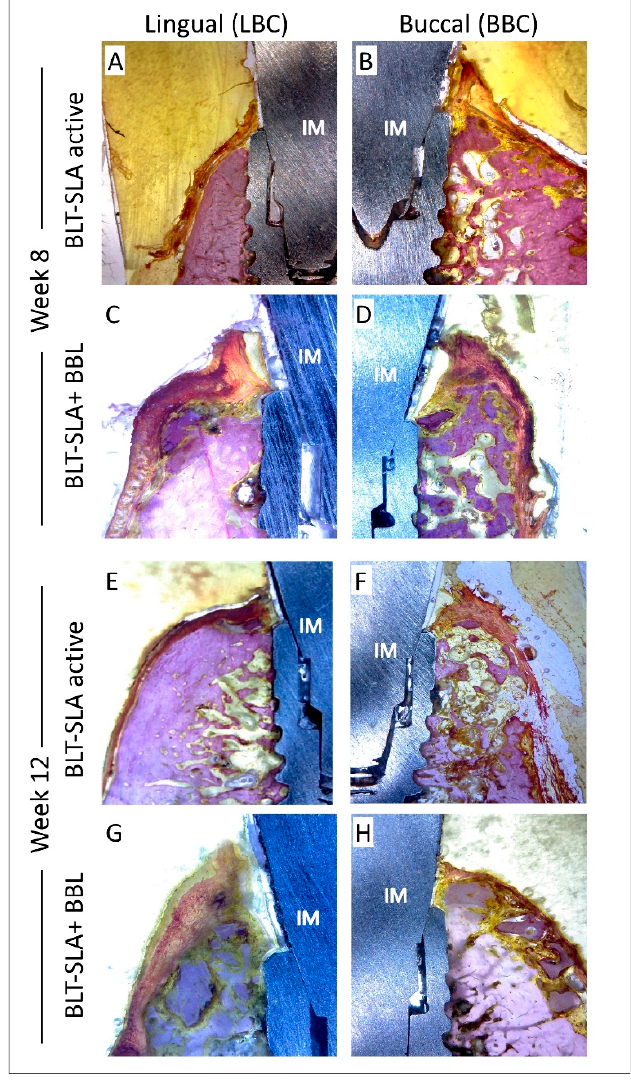
Figure 5. Representative image illustrating the crestal bone loss at week 8 ( A – D ) and 12 ( E – H ) post-implantation assessment. Control group, BLT-SLA active implant A and E lingual (LBC) and B and F buccal (BBC) bone crest. Test group, BLT-SLA pre-treated with BBL. C and G lingual (LBC) and D and H buccal (BBC) bone crest. Pronounced bone and soft tissue regeneration was observed in the test group at week 8. Whereas, at week 12, significant bone maturation and soft tissue amelioration was observed in the test group in comparison to the control group. Magnification 16×.